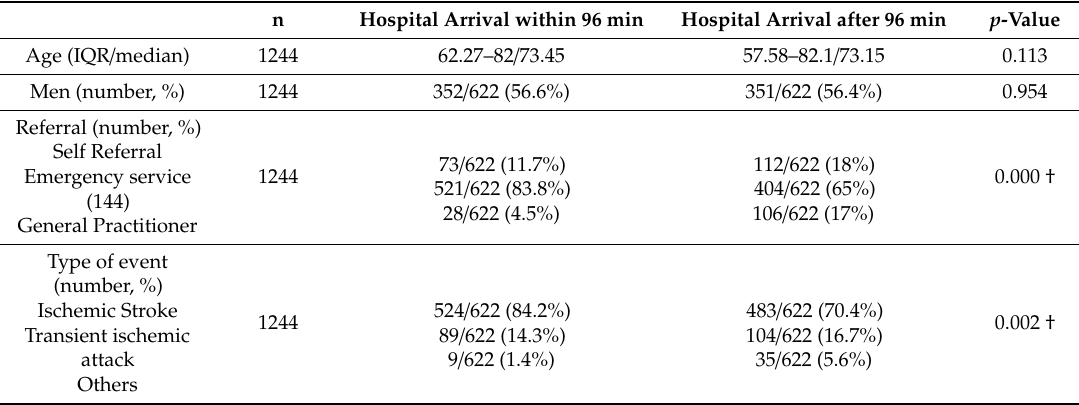
Table A1. Baseline characteristics of patients according to time from symptom onset to hospital